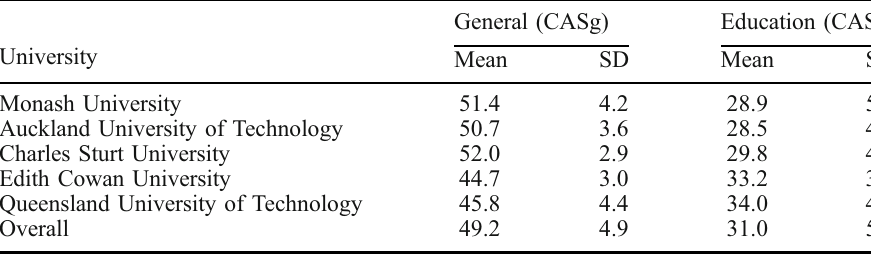
Table 3. Computer Attitudes Survey results.